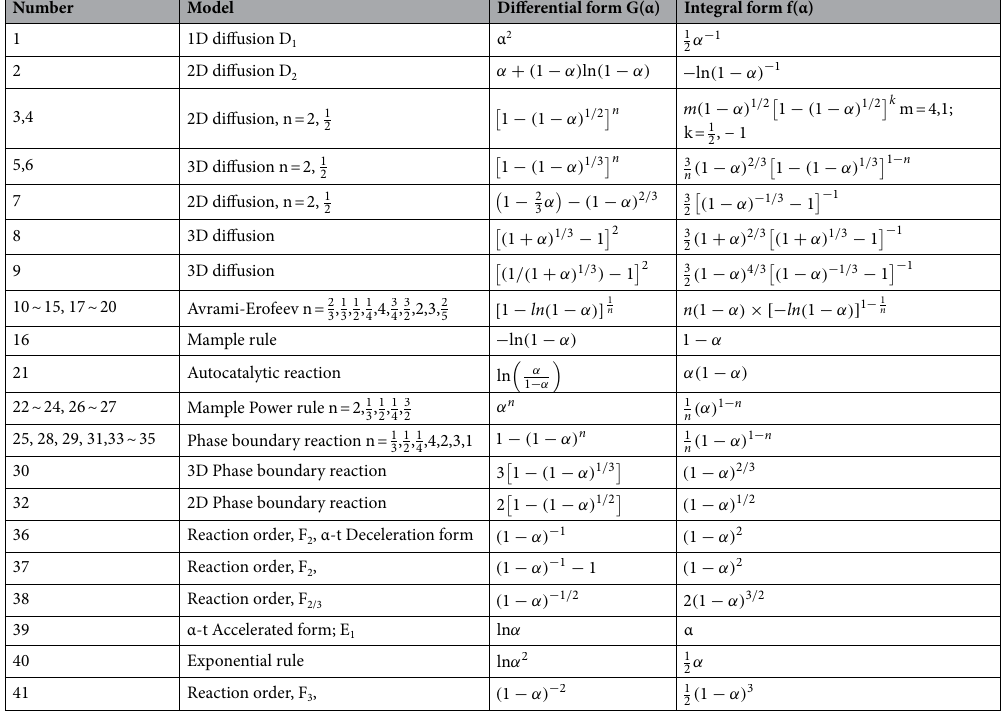
Table 2. Kinetic mechanism function of solid-state reaction based on Malek